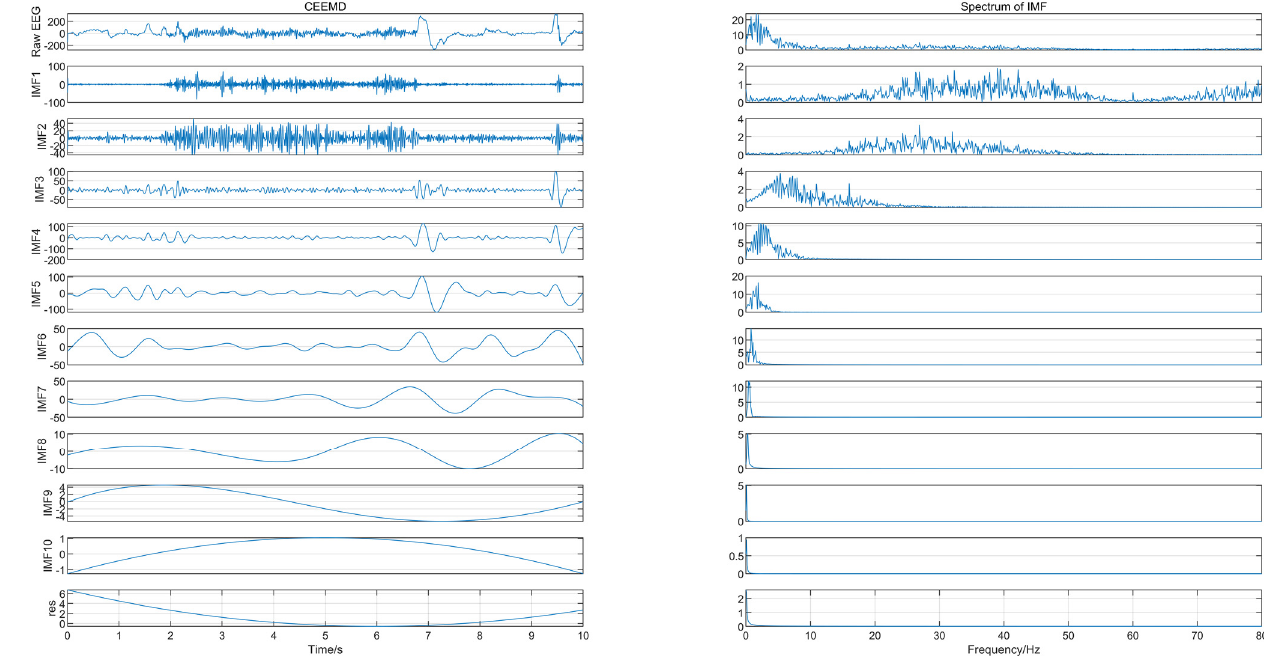
Figure 2. The IMFs and their corresponding spectrum.